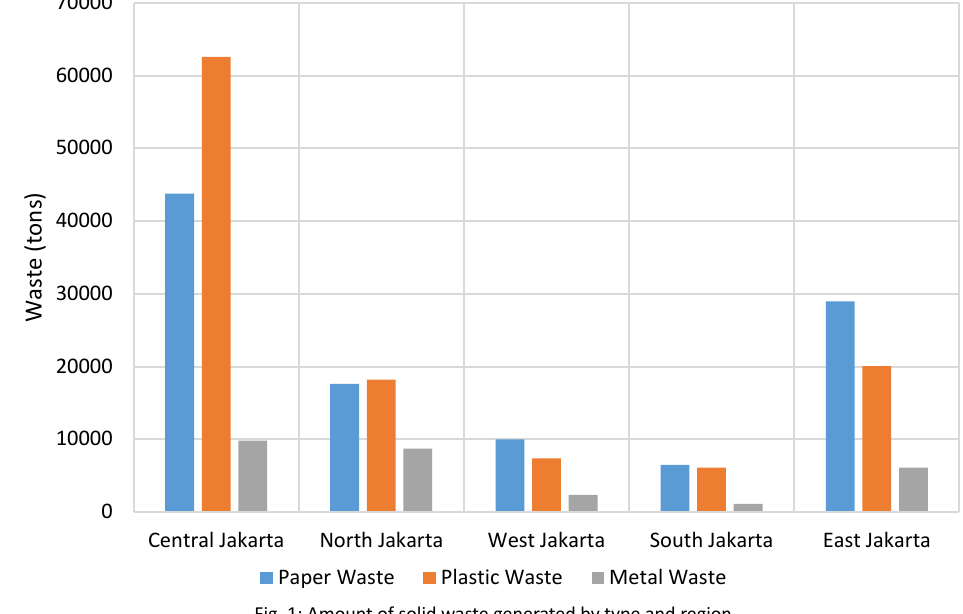
Fig. 1: Amount of solid waste generated by type and region